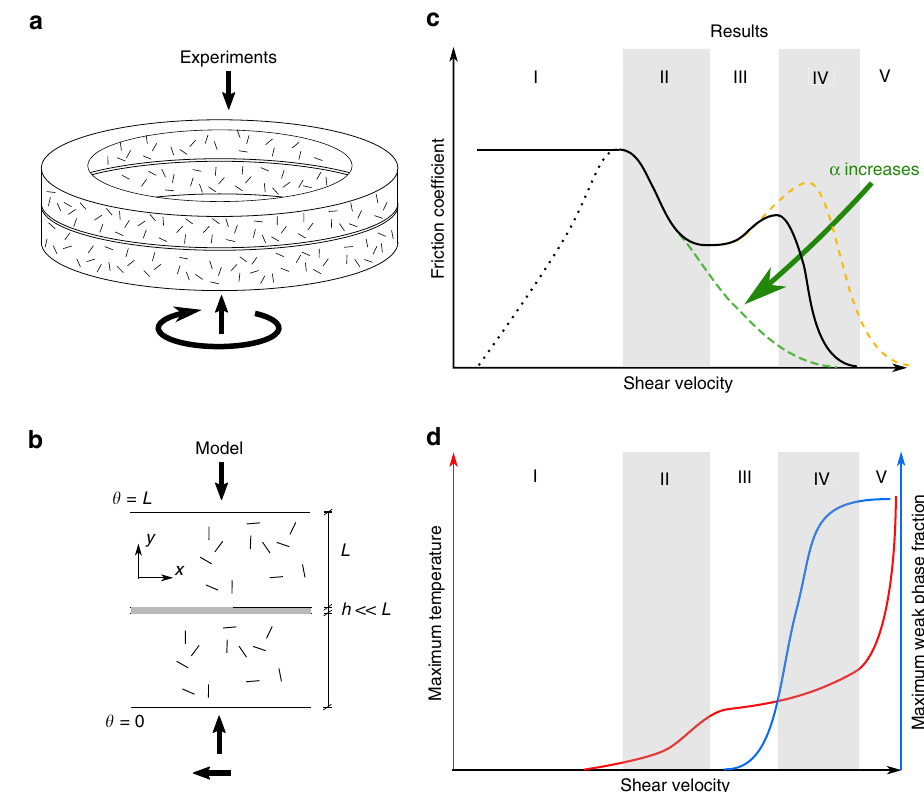
Fig. 2 Presentation of the geometry and steady state of the model. a , b Schematic view of the geometry of the high velocity rotary shear experiments and the model. c , d Steady state of the thermo-chemo mechanical model. Response of the mathematical system of equations (Eqs. (5), (6) in Methods section) at steady state. c The steady state friction coef fi cient as a function of velocity, for varying weak phase sensitivity coef fi cient α . d The steady-state temperature and weak phase content dependency on the velocity, plotted for the black line of c . The fi ve regimes (I – V) that can be observed in the response of the friction coef fi cient are correlated with the temperature and weak phase production processes, as explained in the main